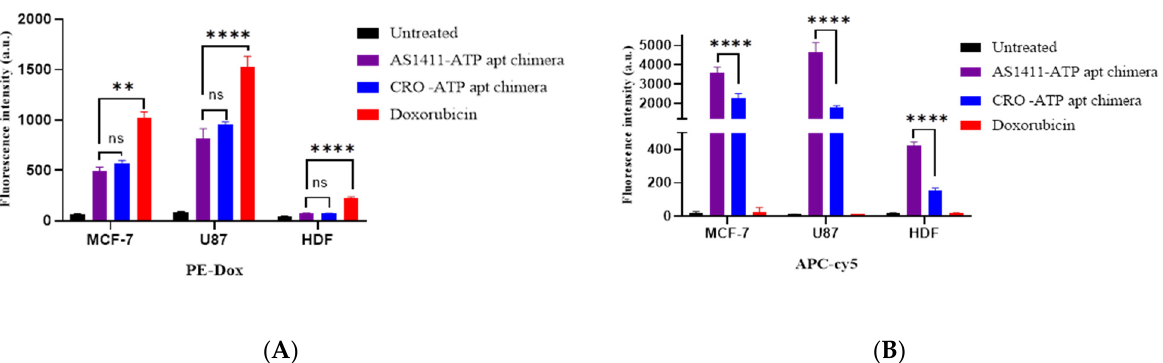
Figure 9. FACS analysis of cellular uptake of the generated chimeras in MCF-7, U87, and HDF after incubation with free doxorubicin and doxorubicin loaded in chimeras. ( A ) Fluorescence intensity of doxorubicin. ( B ) Fluorescence intensity of Cy5. Error bars indicate SD ( n = 3). ** p < 0.01, **** p < 0.0001 (one-way ANOVA).